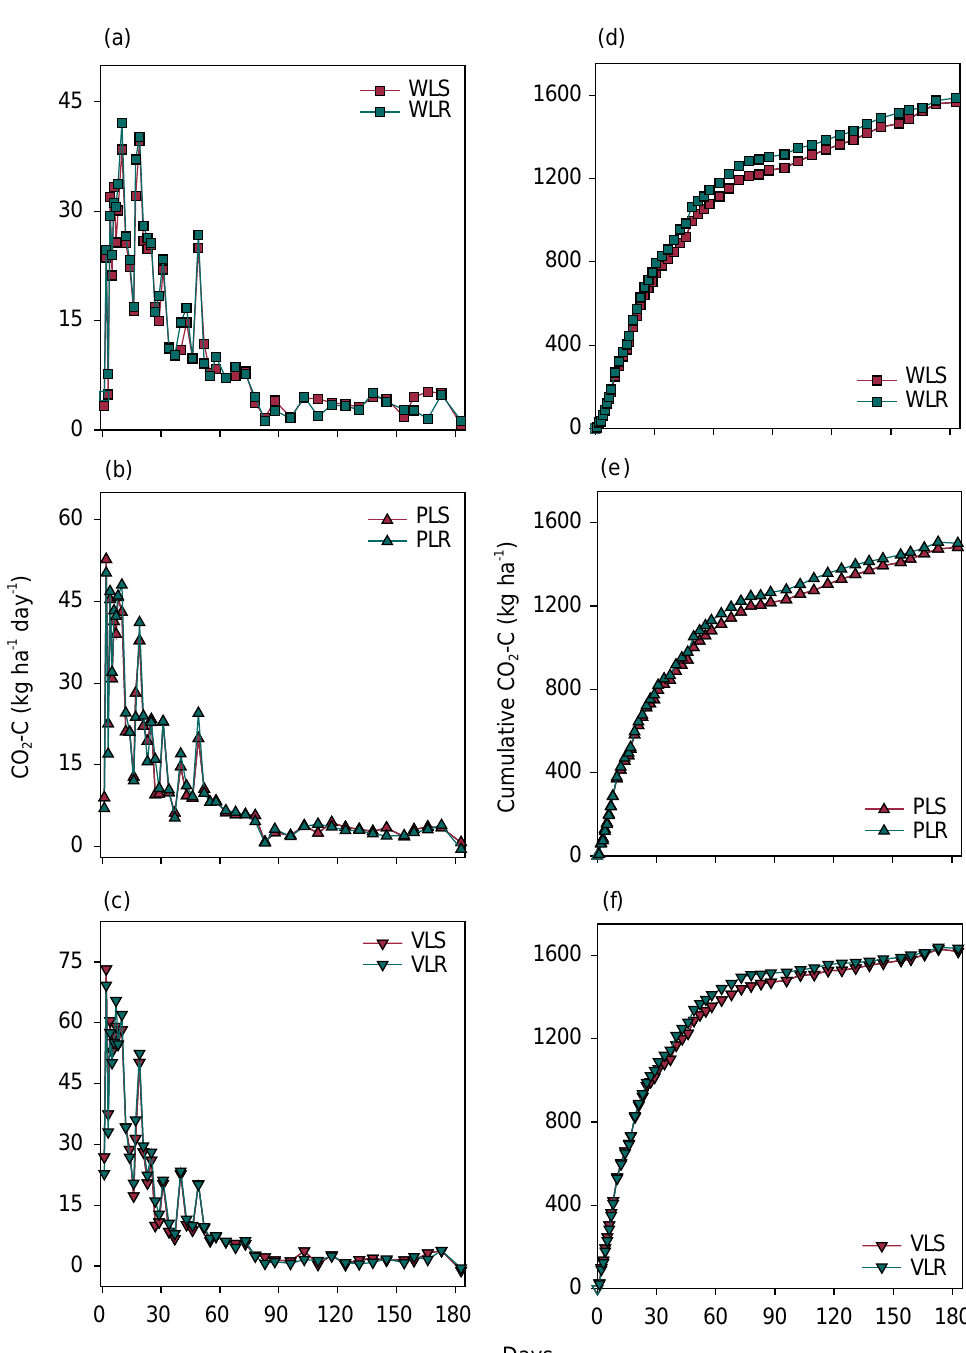
Figure 4. Carbon mineralization rates (a, b, c) and cumulative C mineralization (d, e, f) of wheat shoot labeled (WLS) and wheat root labeled (WLR) (a, d), pea shoot labeled (PLS) and pea root labeled (PLR) (b, e), and vetch shoot labeled (VLS) and vetch root labeled (VLR) (c, f) residues in soil during the 180-day experiment under field